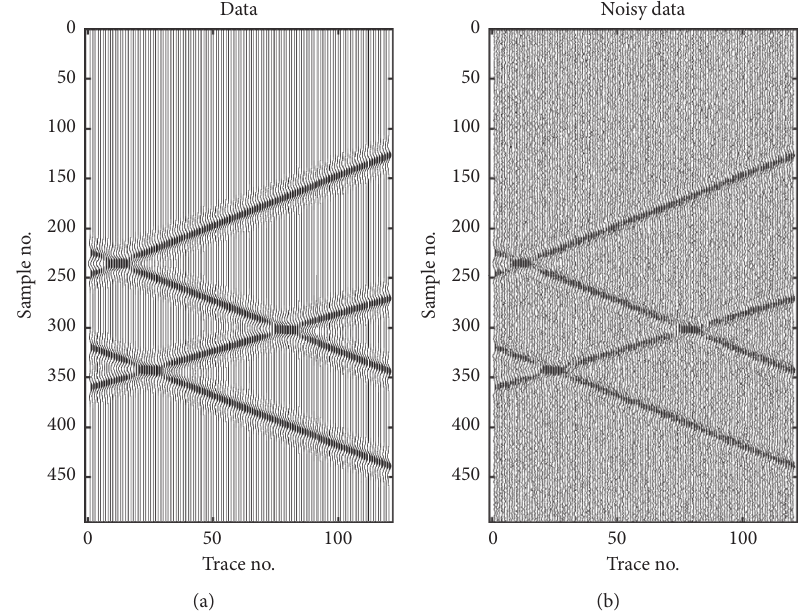
Figure 4: Seismic record of the linear model. (a) Original signal. (b) Data with Gaussian white noise (S/R � 0